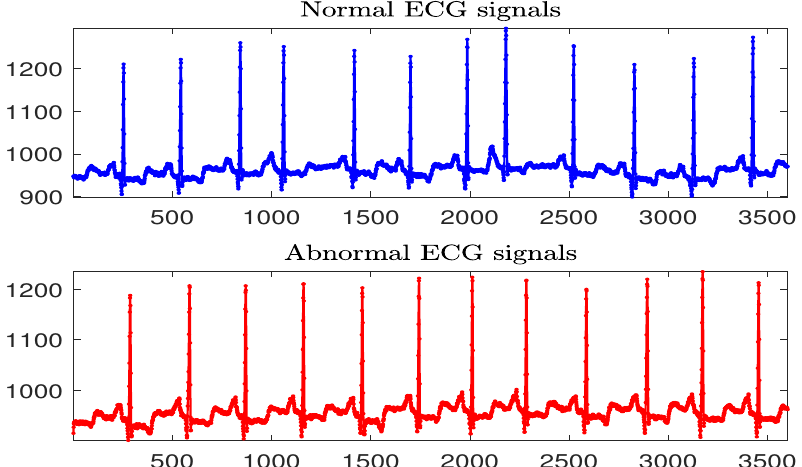
Figure 10. Normal and abnormal 10 s ECG segment. A color version of the figure is available in the web version of the